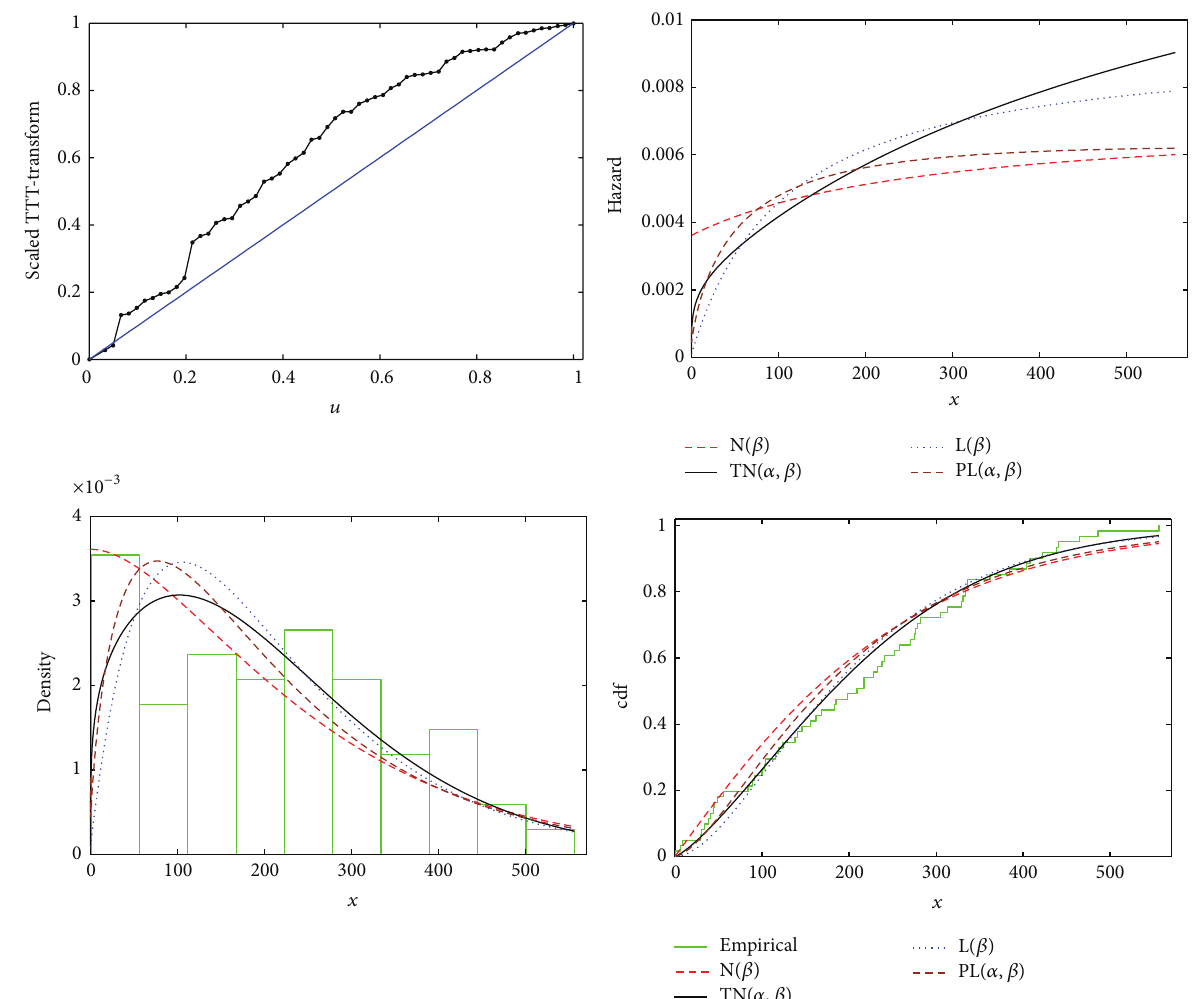
Figure 8: The TTT-transform, fitted hazard, pdf, and cdf of the failure times